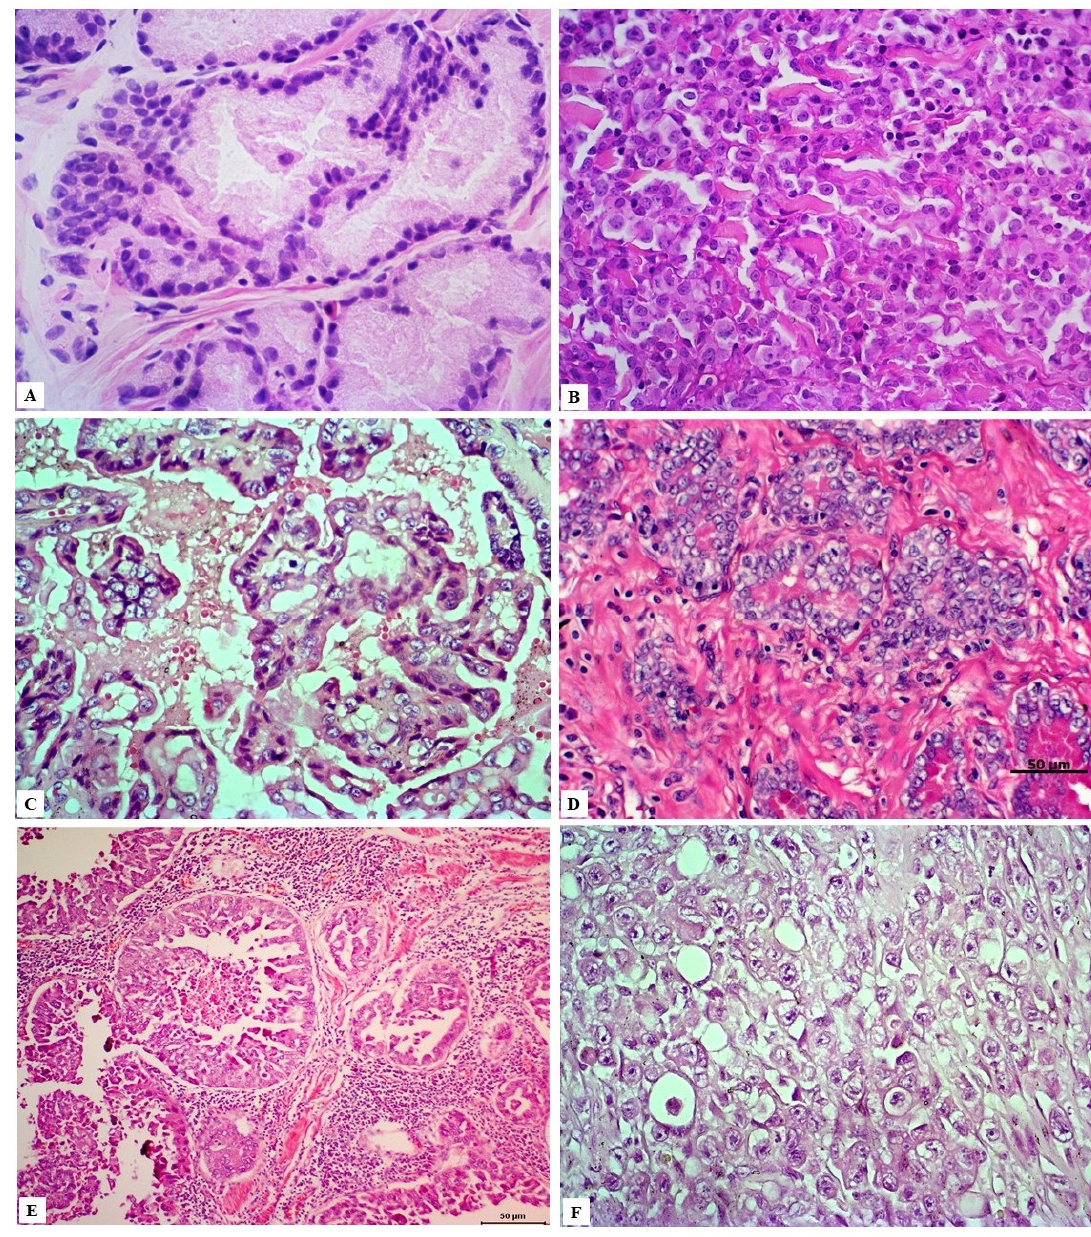
Figure 2. Histological patterns of canine PC. ( A ) Normal prostate. HE, 200 × . ( B ) Solid/undifferentiated, showing pleomorphic cells with no specific growth pattern. HE, 200 × . ( C ) Papillary, represented by neoplastic ductal epithelial cells exhibiting tubulopapillary projections. HE, 200 × . ( D ) Small acinar streaky by dense fibrovascular stroma. HE, 50 µ m. ( E ) Cribriform, characterized by neoplastic ductal cells forming irregular fenestrae with a central area of necrosis. HE, 50 µ m. ( F ) Signet ring cells characterized by intracytoplasmic vacuolization with nuclear displacement to the periphery. HE, 200×.